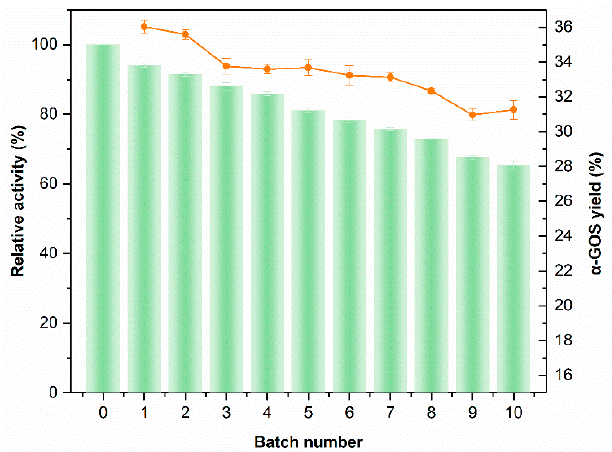
Figure 6. Batch synthesis of α -GOSs by recycling Aga-CLEAs. Column and line charts represent residual enzyme activity and oligosaccharide yield, respectively. Data represent the means of three experiments and error bars represent standard deviation.